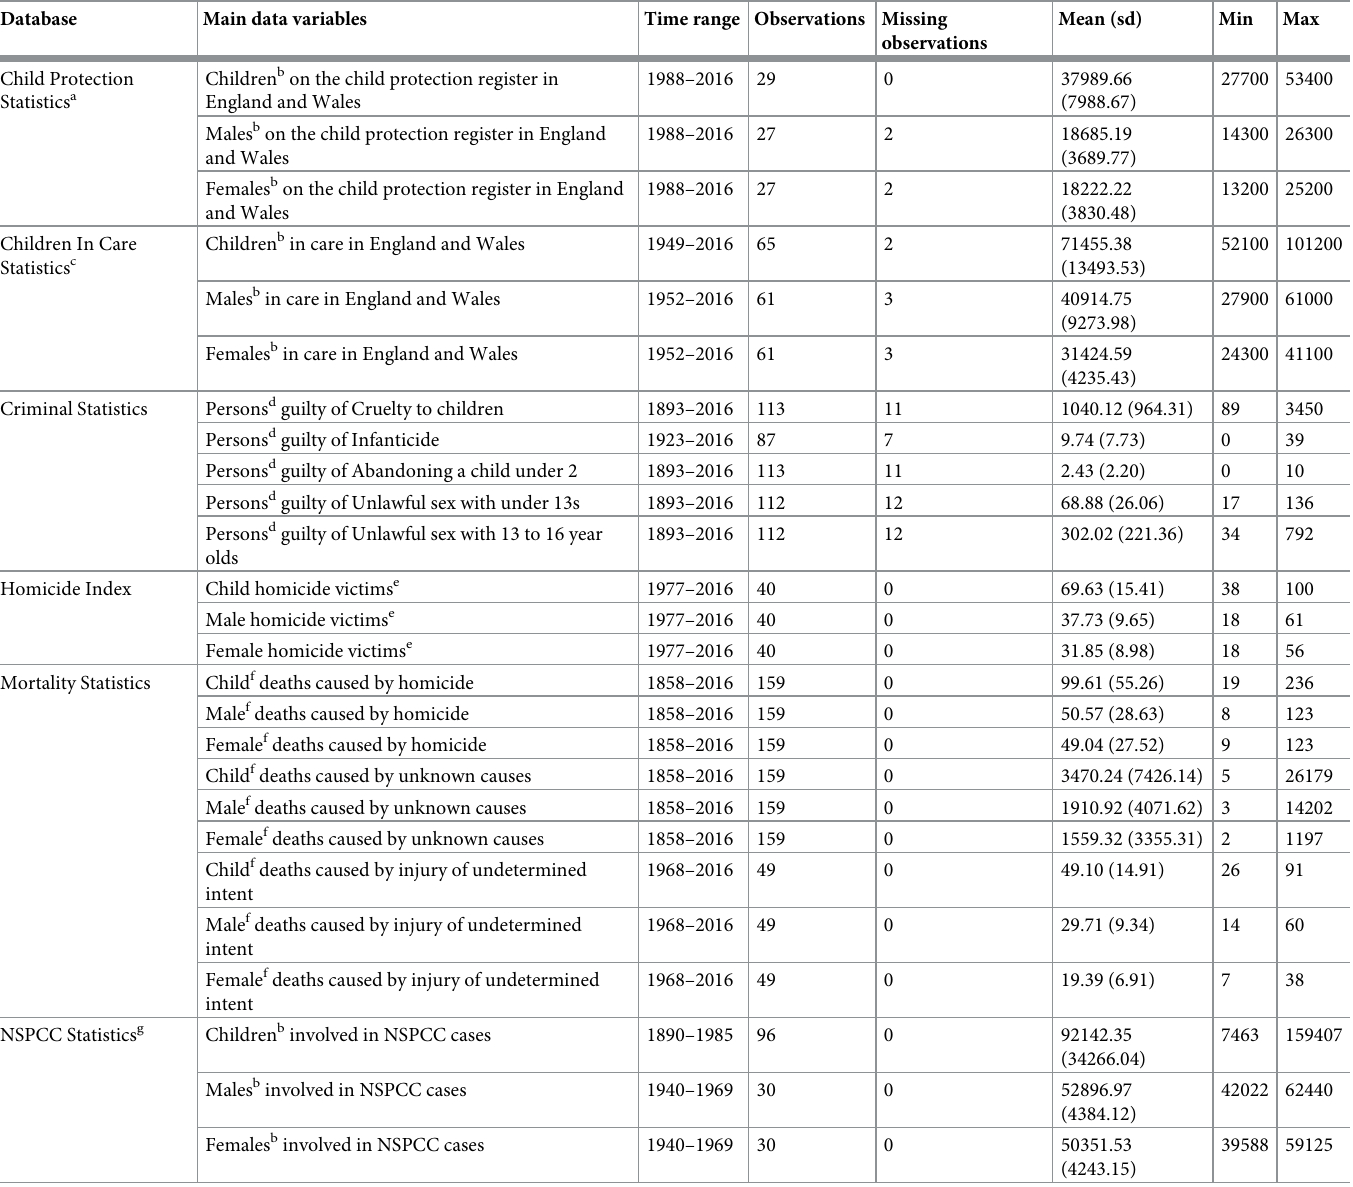
Table 2. Descriptive statistics of main data